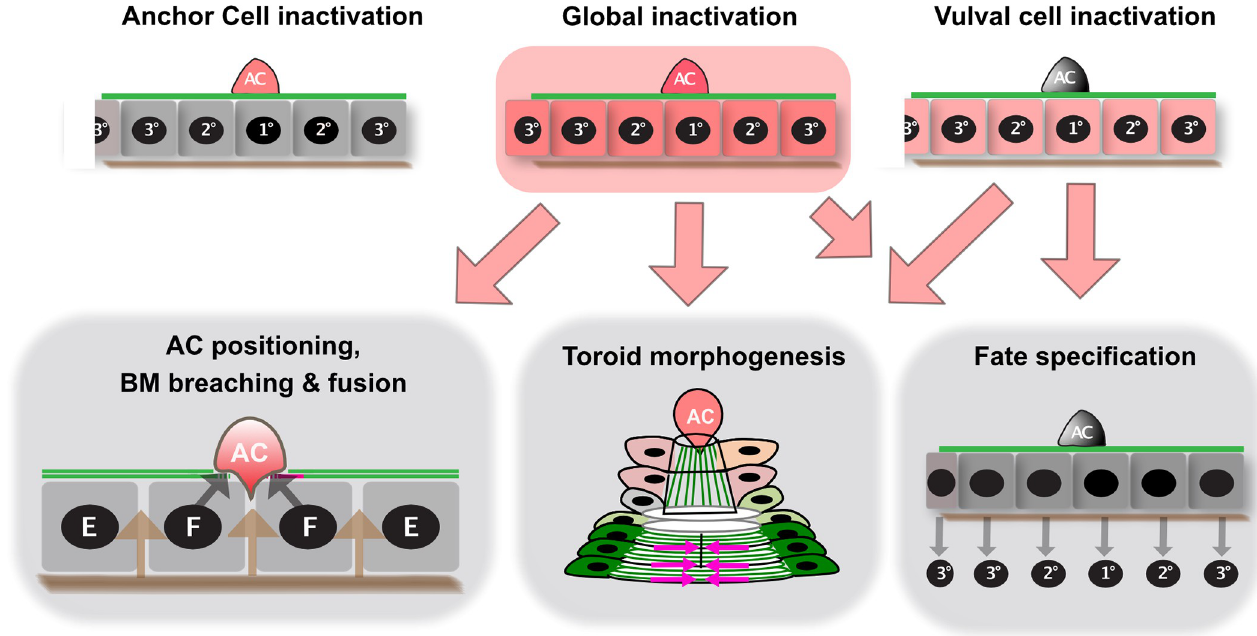
Fig 6. Overview of the different phenotypes observed after SUMO pathway inactivation. Global inactivation of the SUMO pathway (center top) perturbs AC positioning, BM breaching and AC fusion in a cell non-autonomous manner, as well as vulval morphogenesis and fate specification. The magenta arrows indicate the direction of contractile forces shaping the toroids. Vulva-specific SUMO inhibition (top right) results in abnormal morphogenesis of the ventral toroids and rare vulval fate specification defects. Inhibition of SUMO only in the AC (top left) does not cause distinctive vulval defects.